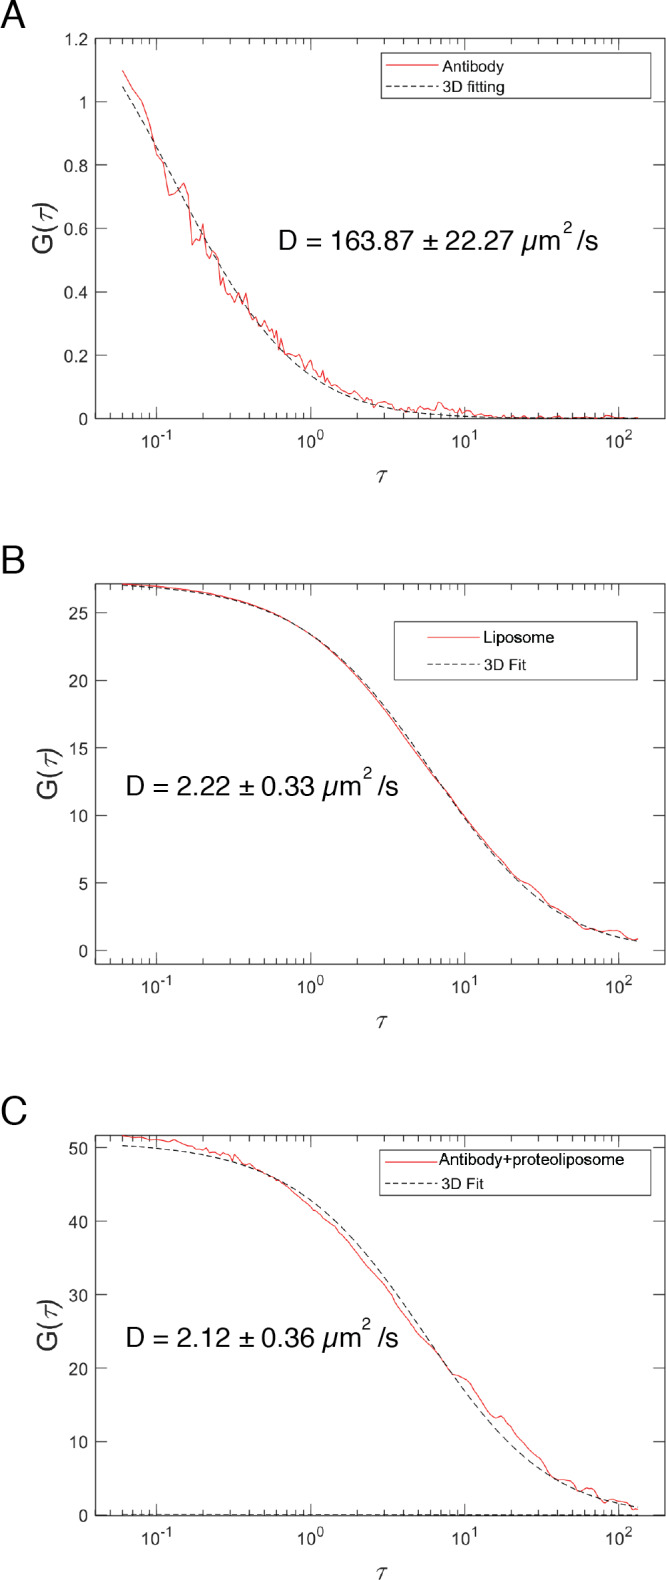
FCS.Fluorescence autocorrelation profiles of TexasRed labeled anti-His antibody in the presence of unlabeled liposomes (A), and TexasRed-PE-labeled liposomes (B), showing diffusion coefficients of unbound antibody versus liposomes. FCS profile of reconstituted l-Opa1 (detected with a TexasRed labeled antibody) (C) is similar to that of dye-labeled liposomes (B), indicating successful reconstitution of Opa1.Figure 2—figure supplement 5—source data 1.FCS.